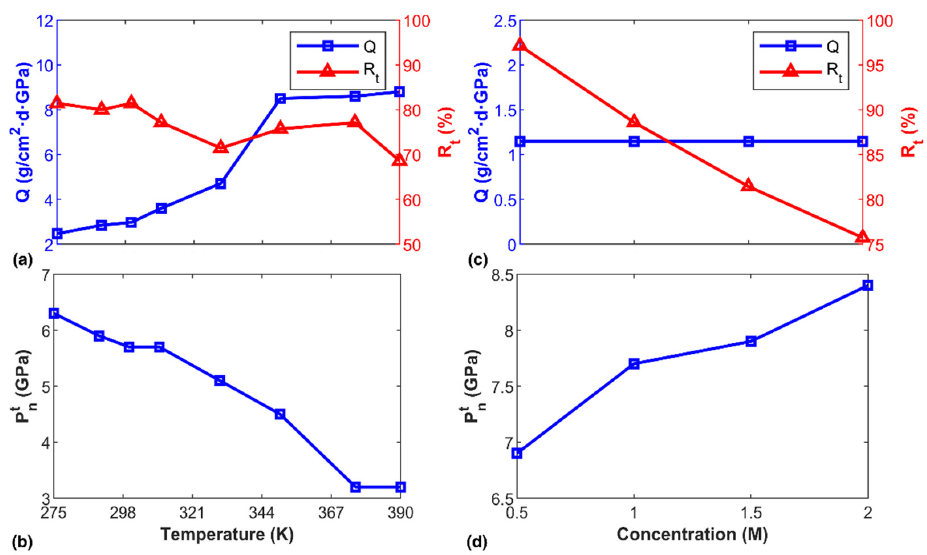
Figure 7. Transportation properties under different temperature and ion concentration. ( a ) The water flux and ion retention rate as a function of temperature; and ( b ) the corresponding transition pressure; ( c ) The water flux and ion retention rate as a function of ion concentration; and ( d ) the corresponding transition pressure.